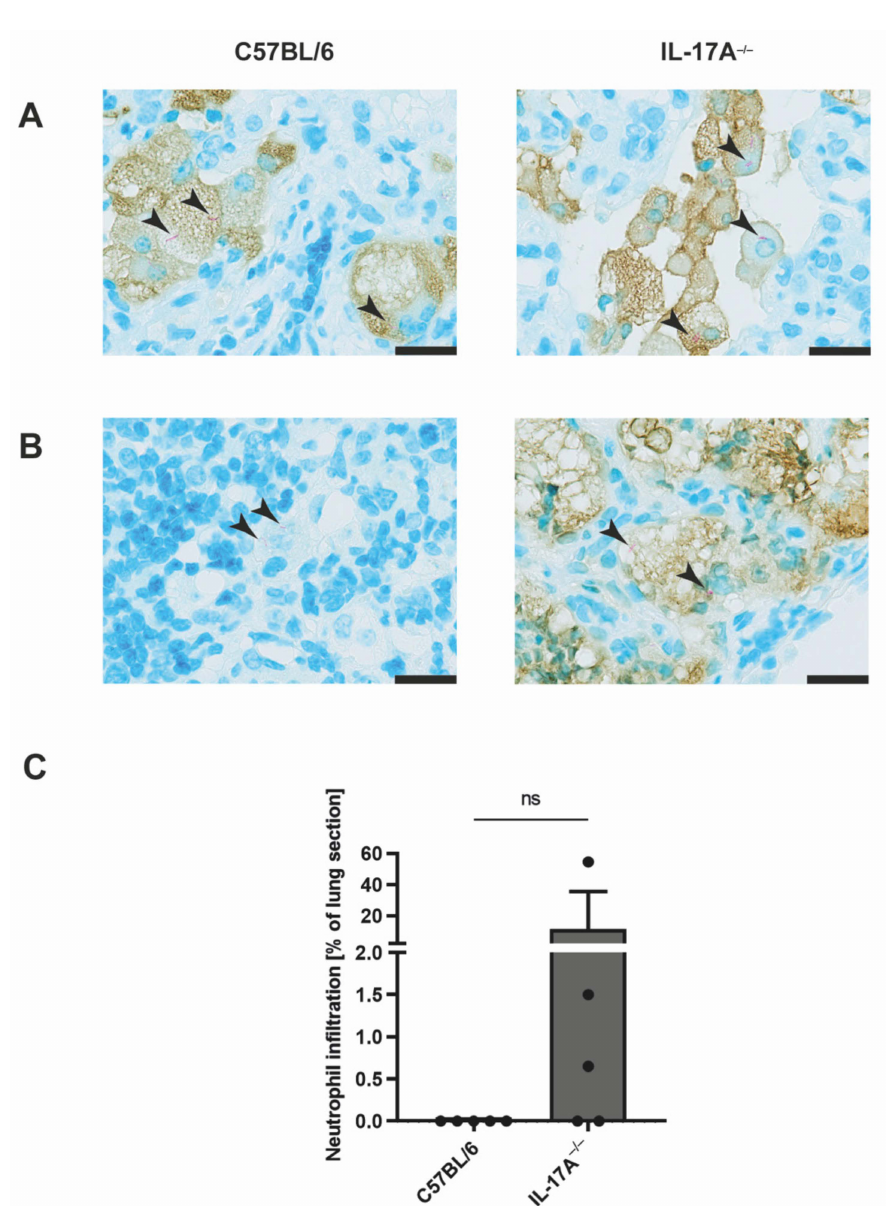
Figure 3. In the absence of IL-17A, infection with elevated doses of Mtb partially provokes increasing infiltration of Mtb-containing neutrophils. ( A – C ) C57BL/6 and IL-17A − / − mice were infected with 100–1000 CFU of H37rv Mtb by an aerosol. In formalin-fixed lung sections taken on Day 199 post- infection, acid-fast bacilli were detected by Ziehl–Neelsen staining. In addition, the sections were co-stained for NOS2 ( A ) or neutrophils ( B , C ). ( A , B ) Representative sections from 1 out of 5 mice per group are shown (magnification: 1000 × , bar: 20 µ m, black arrows: acid-fast bacilli). ( C ) Proportions of neutrophil infiltration within the total area of the lung sections were determined in 4–8 serial sections per animal. Data are presented as single dots and as the mean ± SD of 5 mice per group from one representative experiment. Statistical analyses were conducted using a Mann-Whitney test. Differences in the survival kinetics between C57BL/6 and IL-17A − / − mice were defined as significant (ns p ≥